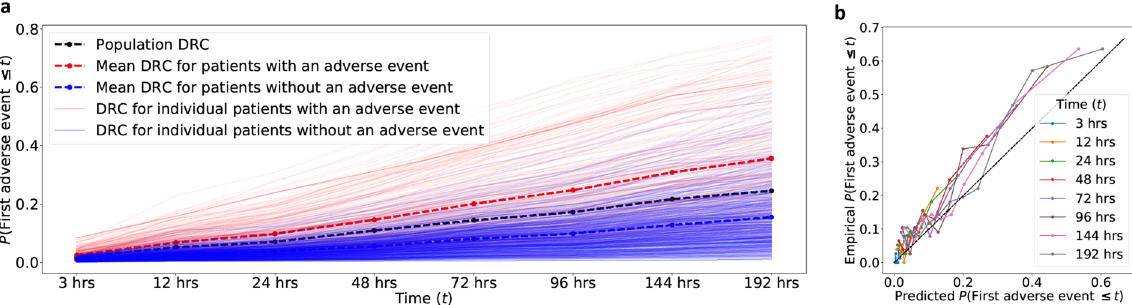
Fig. 4 Deterioration risk curves (DRCs) and reliability plot for COVID-GMIC-DRC. a DRCs generated by the COVID-GMIC-DRC model for patients in the test set with (faded red lines) and without adverse events (faded blue lines). The mean DRC for patients with adverse events (red dashed line) is higher than the DRC for patients without adverse events (blue dashed line) at all times. The graph also includes the ground-truth population DRC (black dashed line) computed from the test data. b Reliability plot of the DRCs generated by the COVID-GMIC- DRC model for patients in the test set. The empirical probabilities are computed by dividing the patients into deciles according to the value of the DRC at each time t . The empirical probability equals the fraction of patients in each decile that suffered adverse events up to t . This is plotted against the predicted probability, which equals the mean DRC of the patients in the decile. Perfect calibration is indicated by the diagonal black dashed